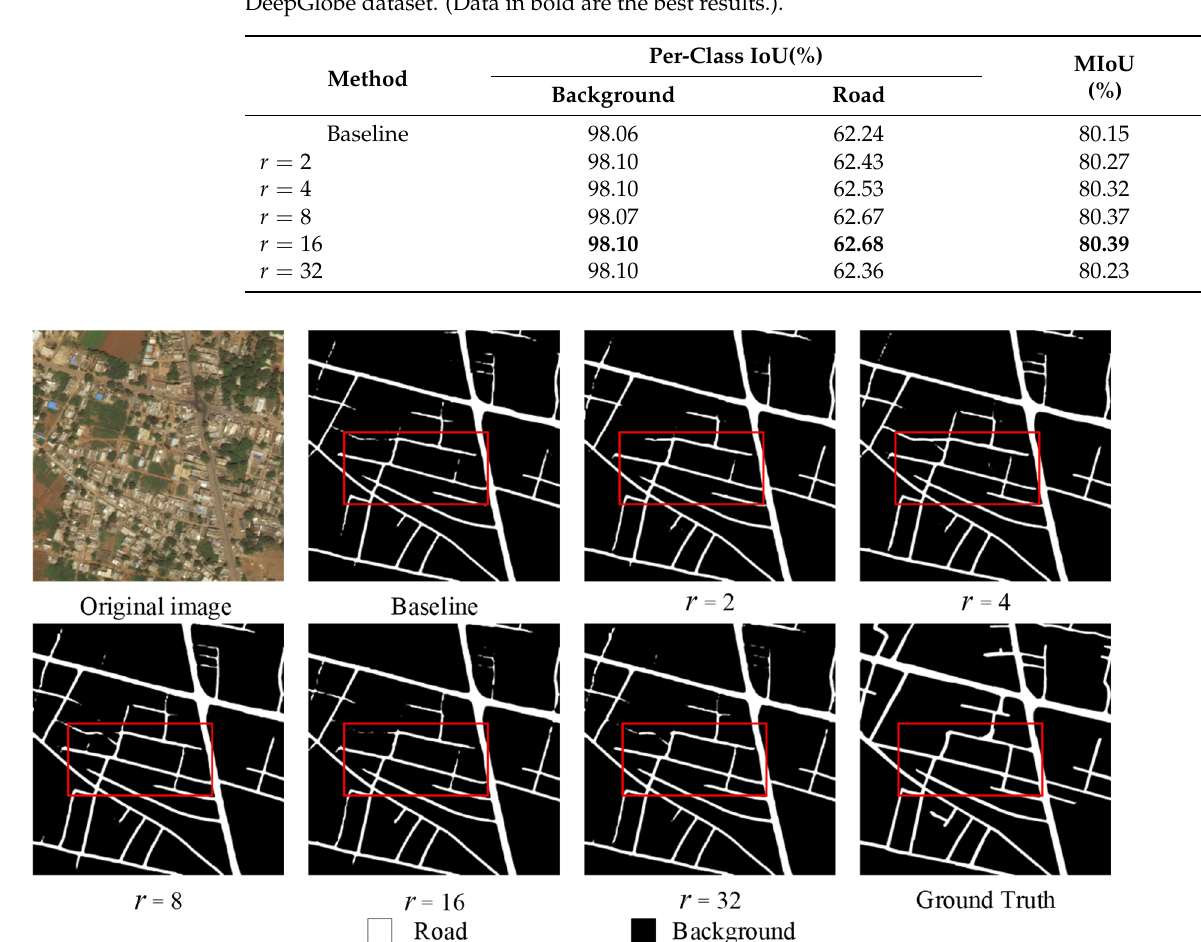
Figure 10. Comparison of visual results of dimensionality reduction based on the DeepGlobe da- taset. Table 3. Comparison of dimensionality reduction rates of strip attention modules based on the CHN6-CUG dataset. (Data in bold are the best